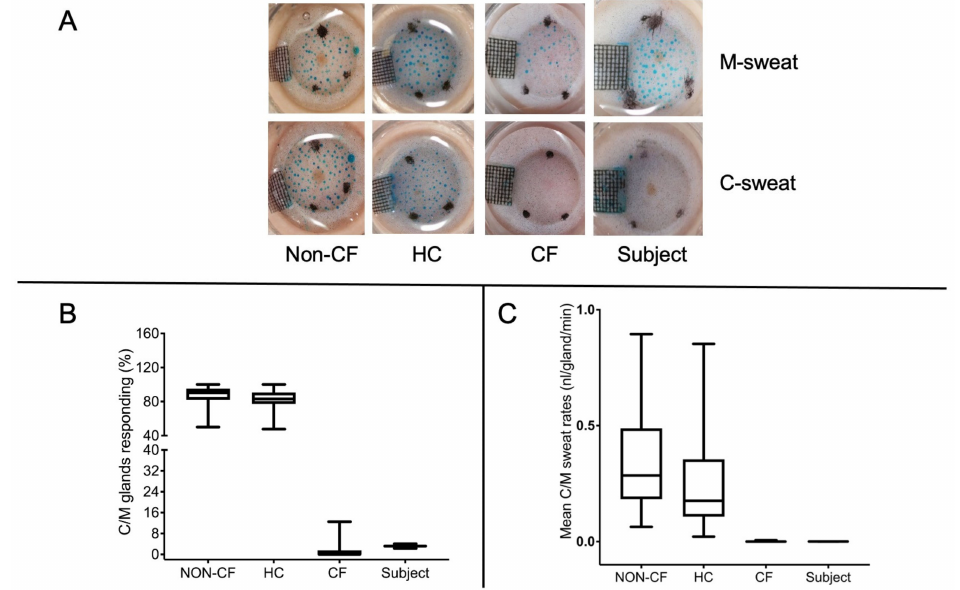
Figure 2. Representative image of M- and C-sweating in the p.[R74W;V201M;D1270N]/CFTR dele22_24 subject. ( A ) Each image focuses on a small region of stimulated forearm skin of the selected subjects to show blue-stained sweat droplets by single sweat glands that responded to methacholine (M-sweating) and to the β -adrenergic cocktail (C-sweating), demonstrating the activity of the CFTR channel (C-sweat); grid scale = 0.5 mm. ( B ) The percentage of glands producing C-sweat in each group (control: non-CF, healthy carriers: HC and cystic fibrosis: CF) and patient analyzed (subject). ( C ) Comparison of average C/M sweat rates measured among the same